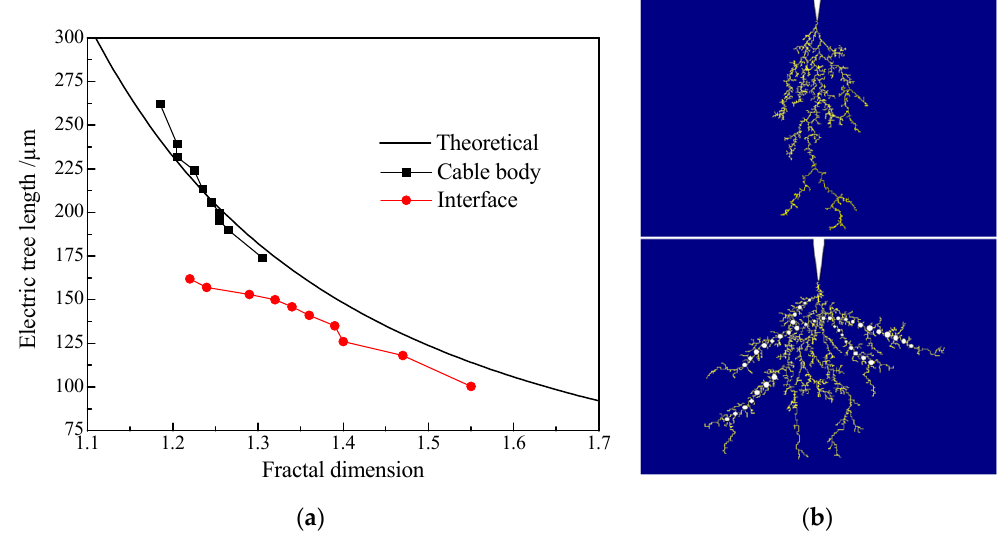
Figure 10. ( a ) Experimental and calculation results of growth length versus fractal dimension of electric trees; ( b ) 2-dimensional simulation results of tree propagation in pure material (up panel) and though a string of polygons (bottom panel) in which the fractal dimension is set as 2 to represent the breakdown process of air micropores in electric tree growth.